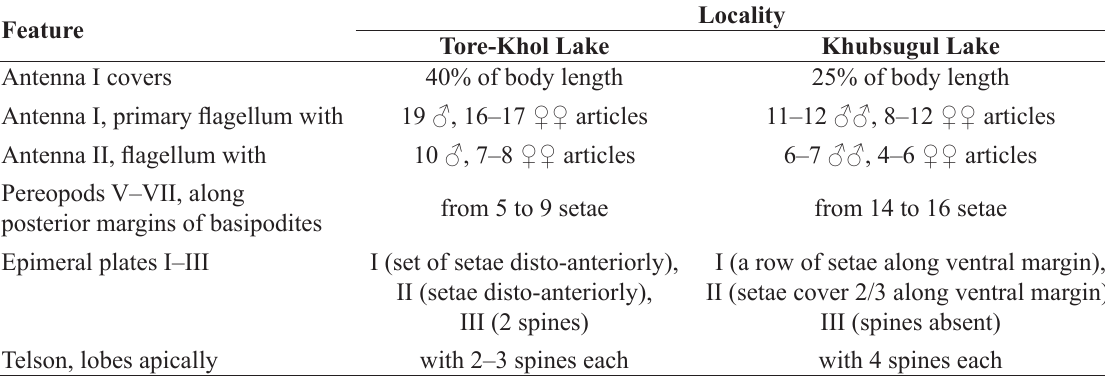
Table 1. Comparison of character differences of Gammarus koshovi (Bazikalova, 1946) from two lacustrine